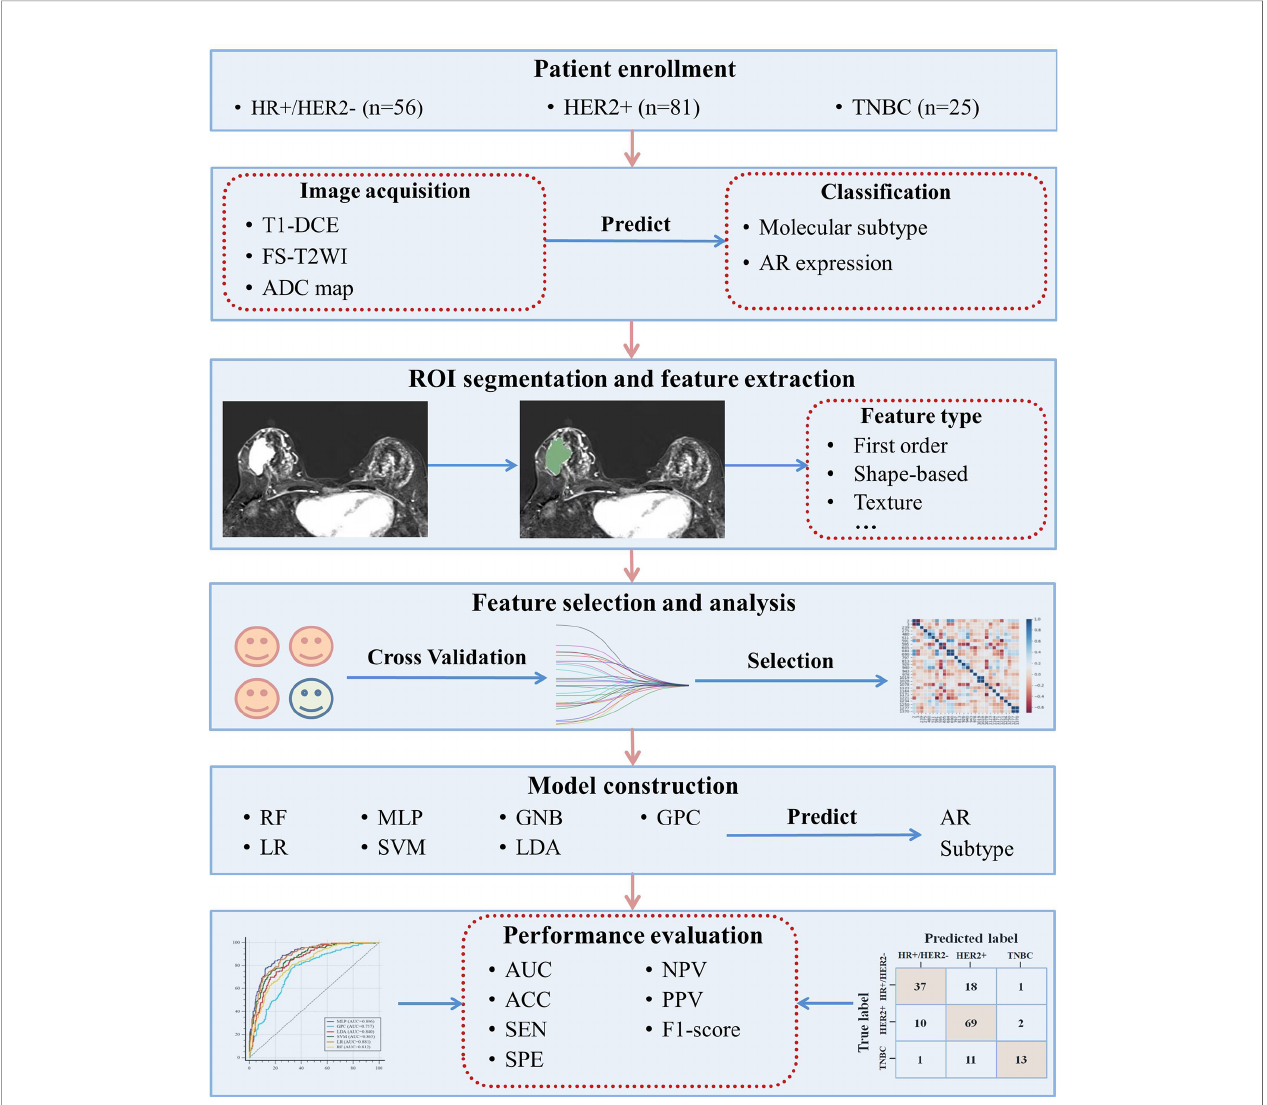
FIGURE 1 | The work fl ow of this